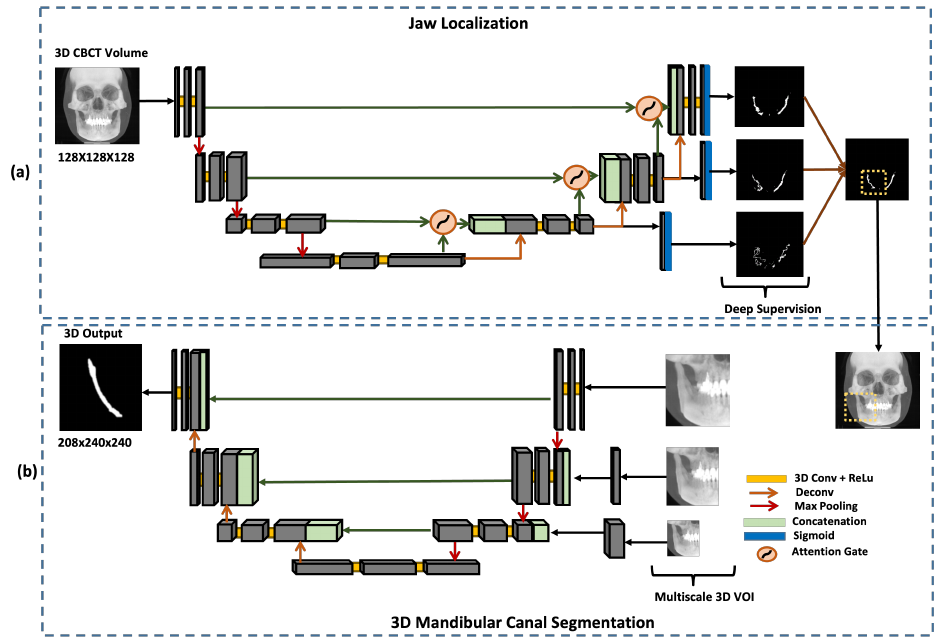
Figure 4. Proposed dual-stage scheme for mandibular canal segmentation, describing the model architectures utilized at each stage. ( a ) Deeply supervised attention UNet model for jaw localization which coarsely segments the canal. ( b ) Multi-scale input ResUNet model used to produce fine segmentation of mandibular canals (i.e., left and right canals).